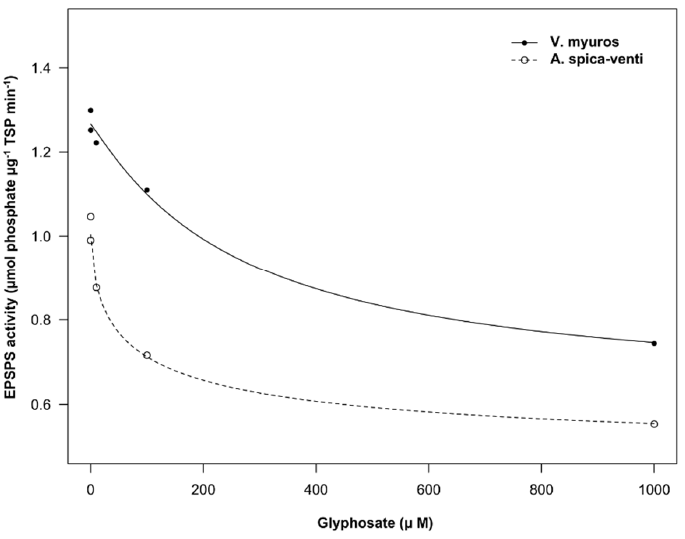
Figure 4. Shikimic acid accumulation in the leaf segment of plants from Vulpia myuros and Apera spica-venti following incubation with different concentrations of glyphosate. Vertical bars represent standard errors of the means.